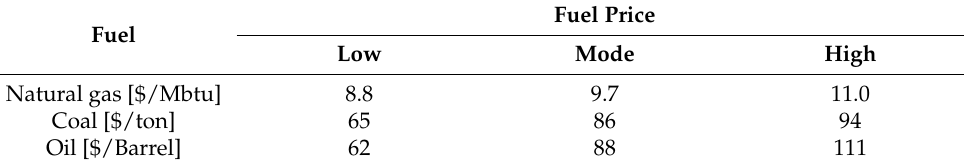
Table 7. Fuel price. Fuel Price Fuel Low Mode High Natural gas [$/Mbtu] Coal [$/ton] 65 94 62